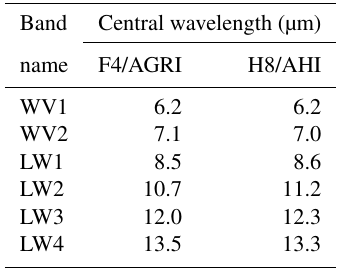
Table 1. Channel information for F4/AGRI and H8/AHI considered in our integration algorithms.